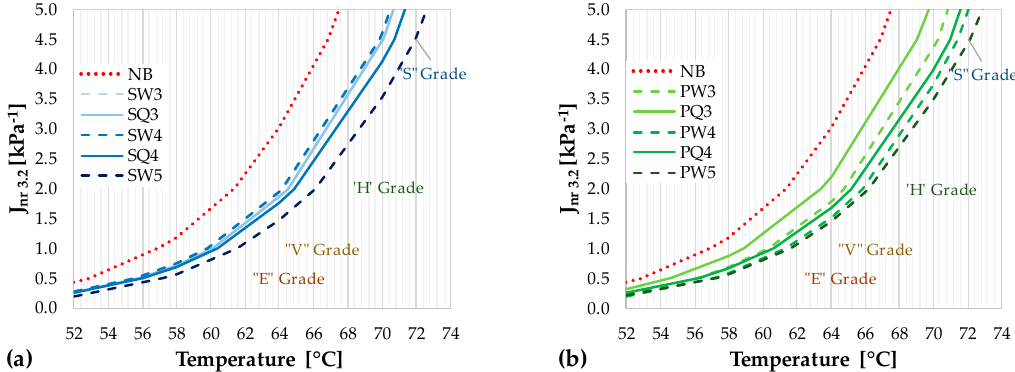
Figure 10. Results of MSCR tests—non-recoverable creep compliance at 3.2 kPa (RTFO-aged binders): ( a ) SBR-modified binders; ( b ) PBR-modified binders. Table 6. High critical temperatures.